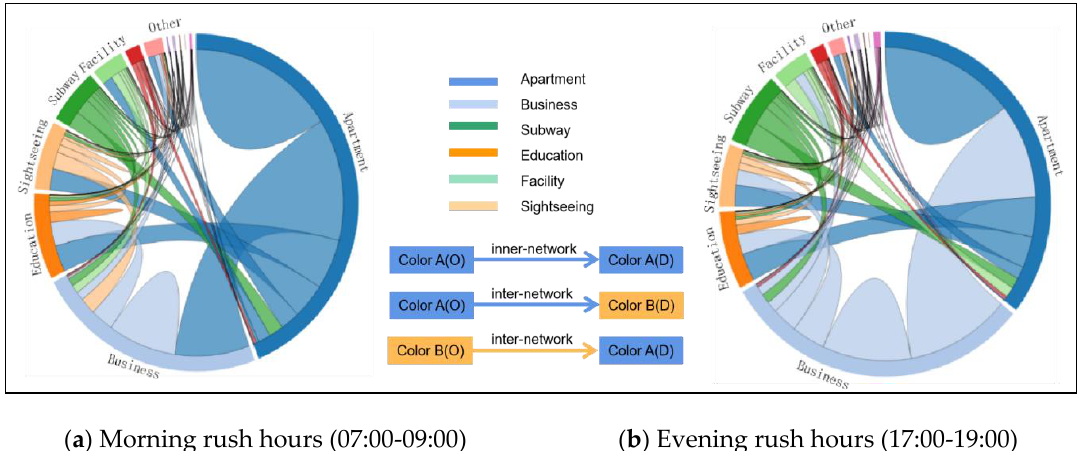
Figure 10. Network flow of taxi trips in Shenzhen City on weekdays.